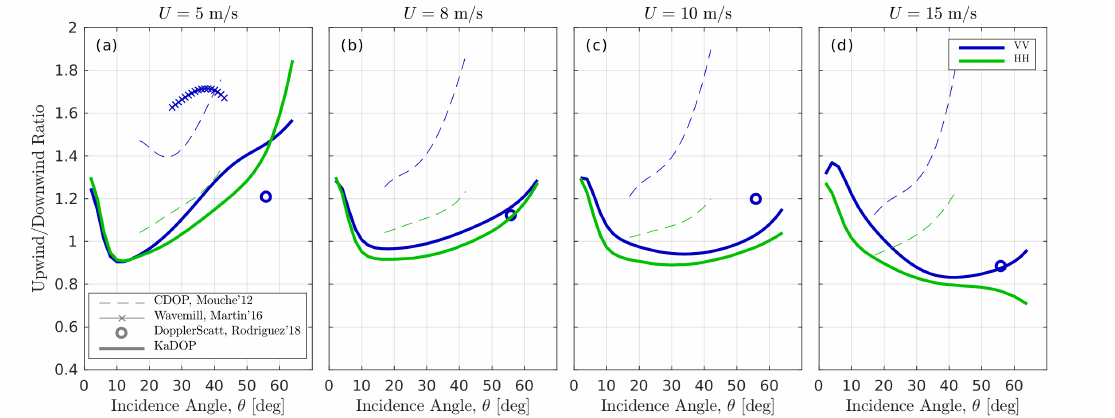
Figure 11. Upwind-to-downwind Doppler centroid ratio versus incidence angle for various wind speeds, U